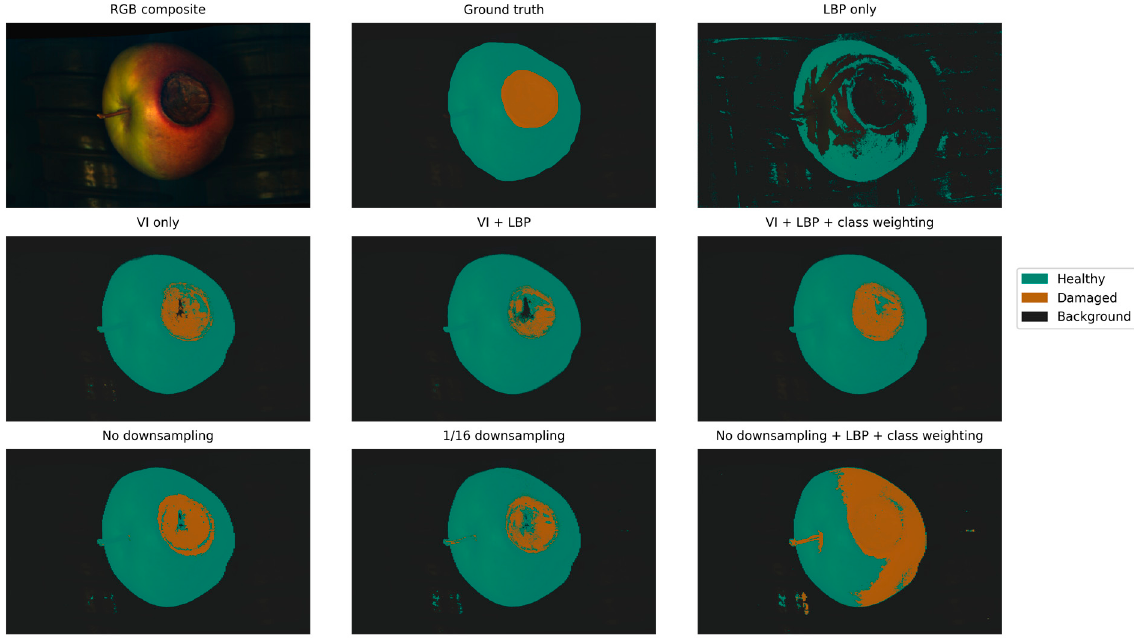
Figure 6. Classification results for an apple with a severe sunburn.